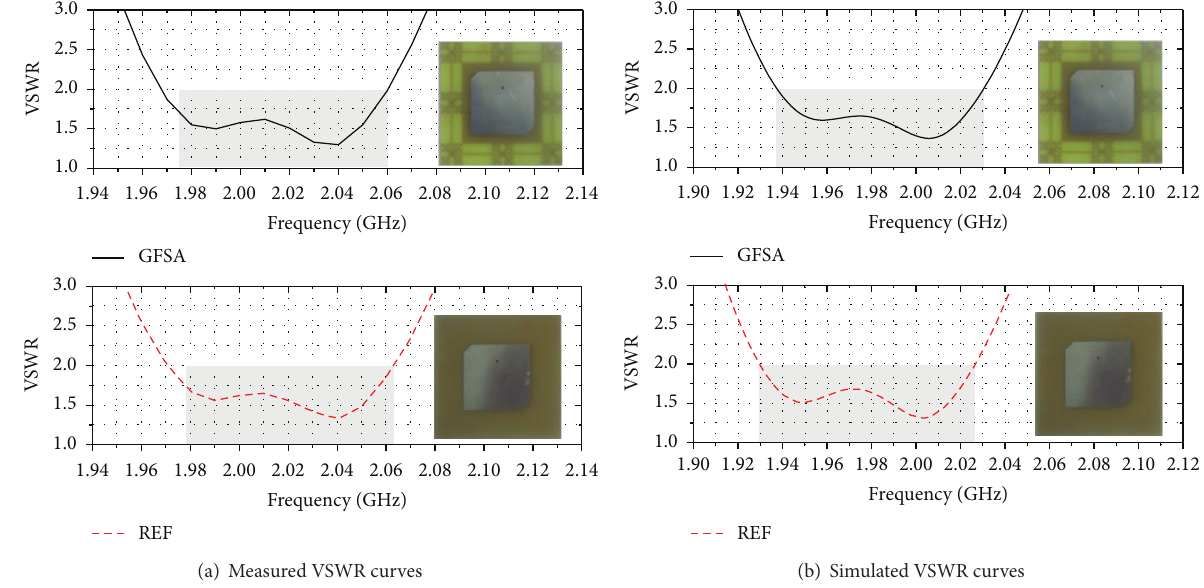
Figure 3: VSWR curves of GFSA and REF.